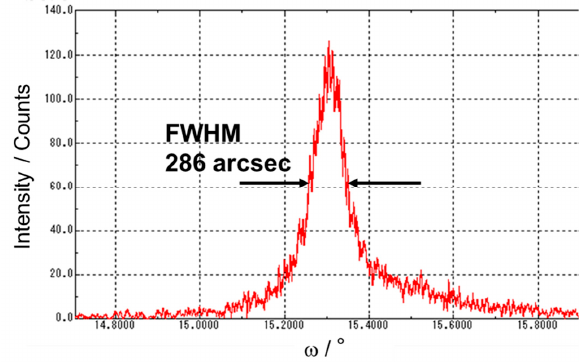
Figure 5. Hf, Yb, and Lu distributions in the grown Yb1%:Lu 0.388 Hf 0.612 O 1.806 .